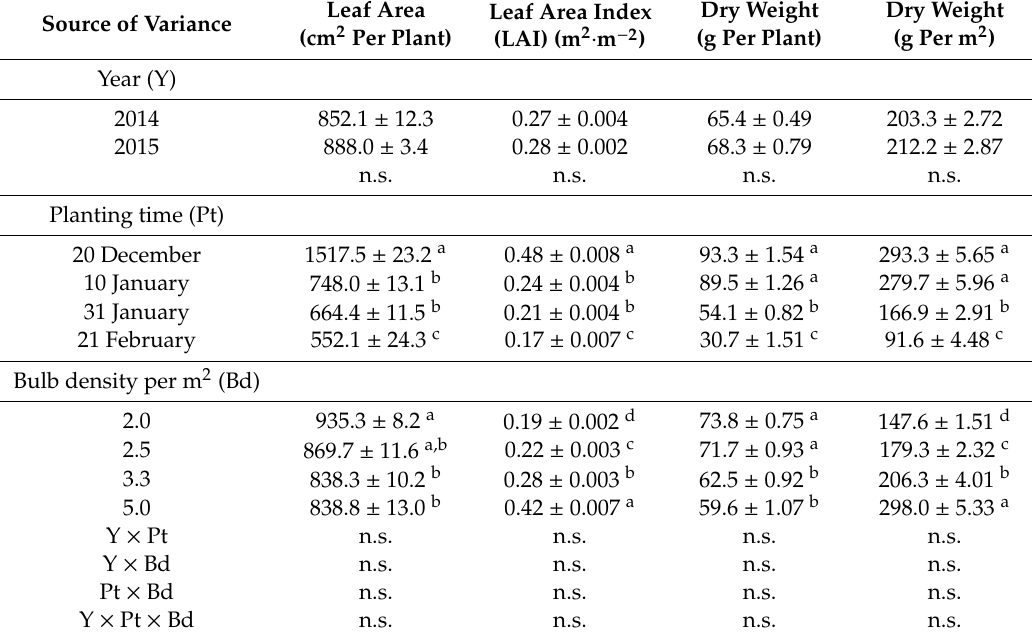
Table 2. Mean values of onion growth indices as a ff ected by bulb planting time and density ( n = 3 ±